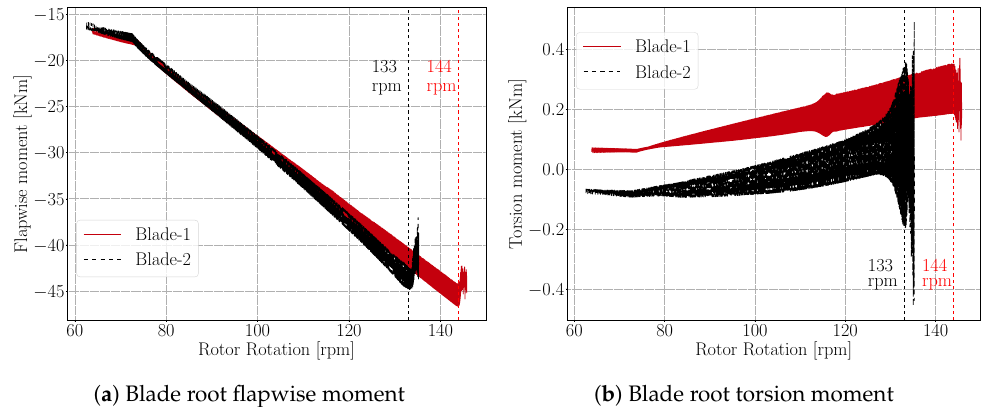
Figure 20. Flapwise and torsion blade root moments with respect to rotor rotation speed. The initial rotational speeds for instability regions are